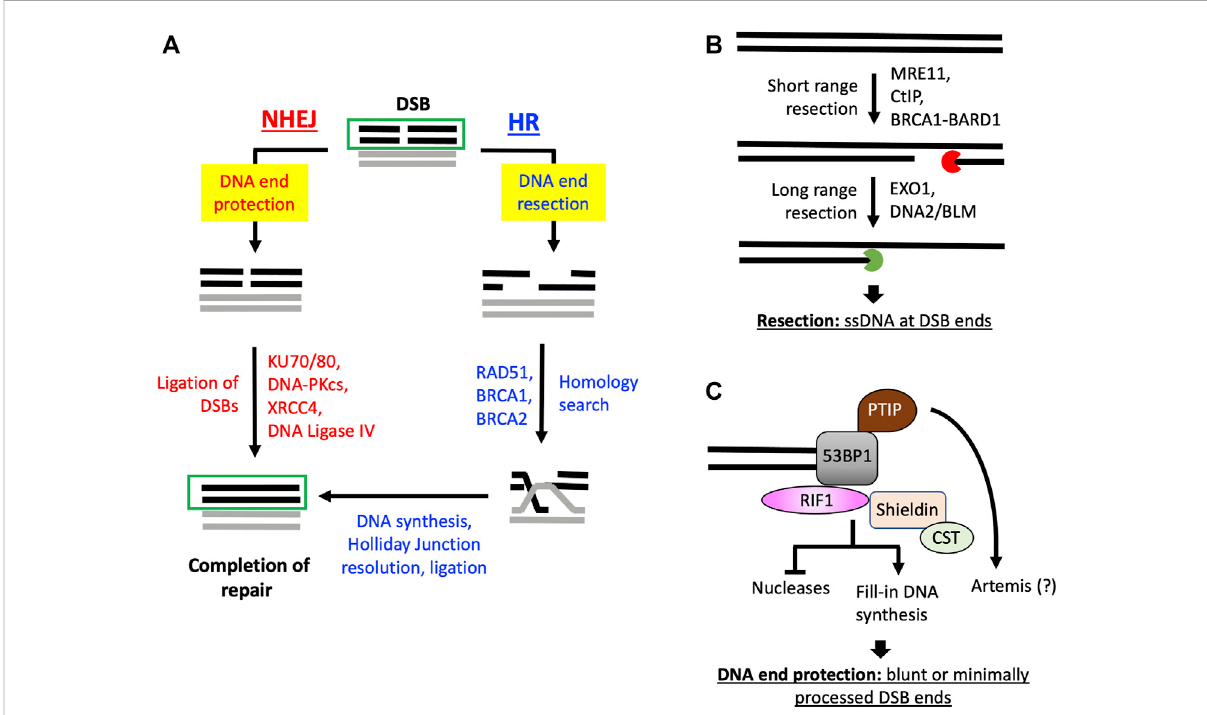
FIGURE 1 DNA resection determines DSB repair pathways choice between HR and NHEJ. (A) DSBs with ends protected by DNA end protection proteins canberepairedbyNHEJ.DSBsmayalsoberesectedbynucleases andaccessory proteinstogeneratessDNAoverhangstopromoteHRandprevent NHEJfunctionatsuchresectedDNAends. (B) Distinctgroupsofnucleases andaccessoryproteinspromoteshort-andlong-rangeresectionofDNA DSBs to generate ssDNA to initiate HR. (C) 53BP1, through different downstream effectors, restricts nuclease activity at DSBs and/or promotes fi ll-inDNAsynthesisatresectedDSBstomaintainbluntorlimitedprocessedDNAendsforNHEJ.Thequestionmark(?)nexttoArtemisindicatesthat although Artemis inactivation allows for DNA resection in BRCA1-de fi cient cells, current evidence indicate it could indirectly affect DNA end processing (see main